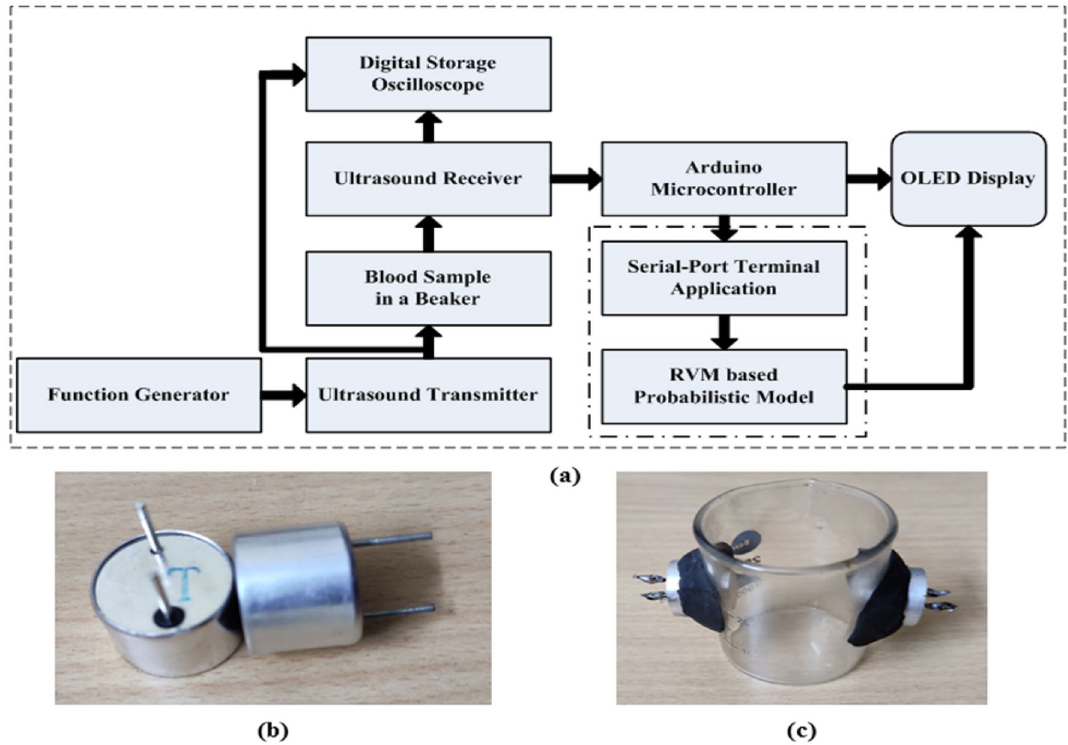
Figure 1. ( a ) Flowchart representation of blood glucose level measurement setup; ( b ) Procured ultrasonic transceiver (WZT40 and WZR40) pair; and ( c ) Sample holder with ultrasonic transceiver (WZT40 and WZR40)